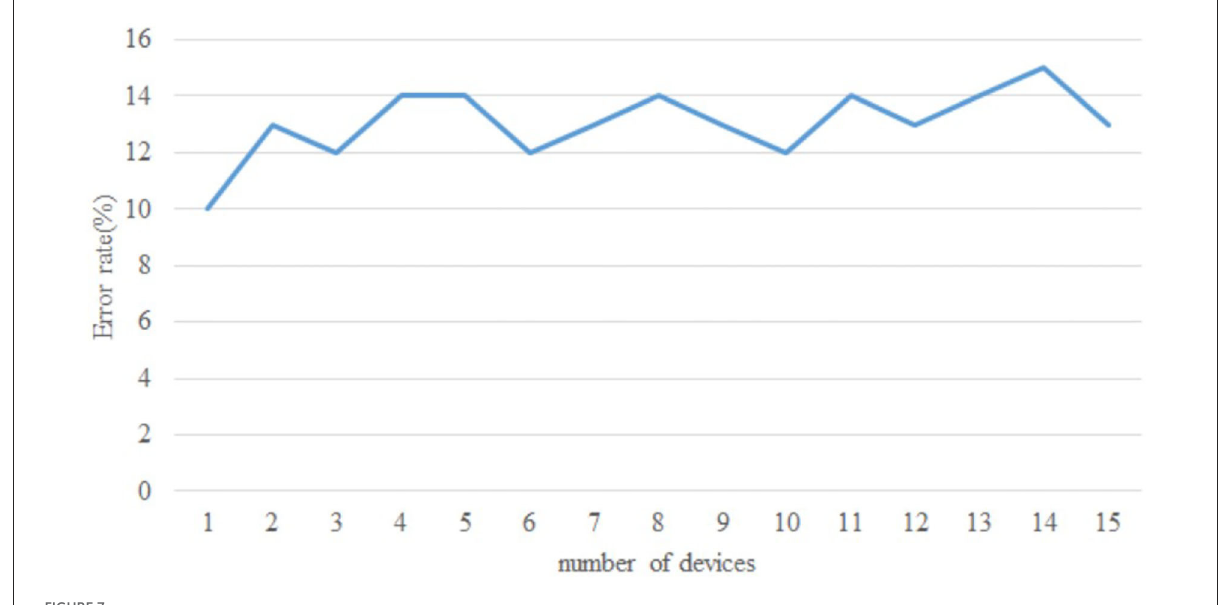
FIGURE7 Route planning error